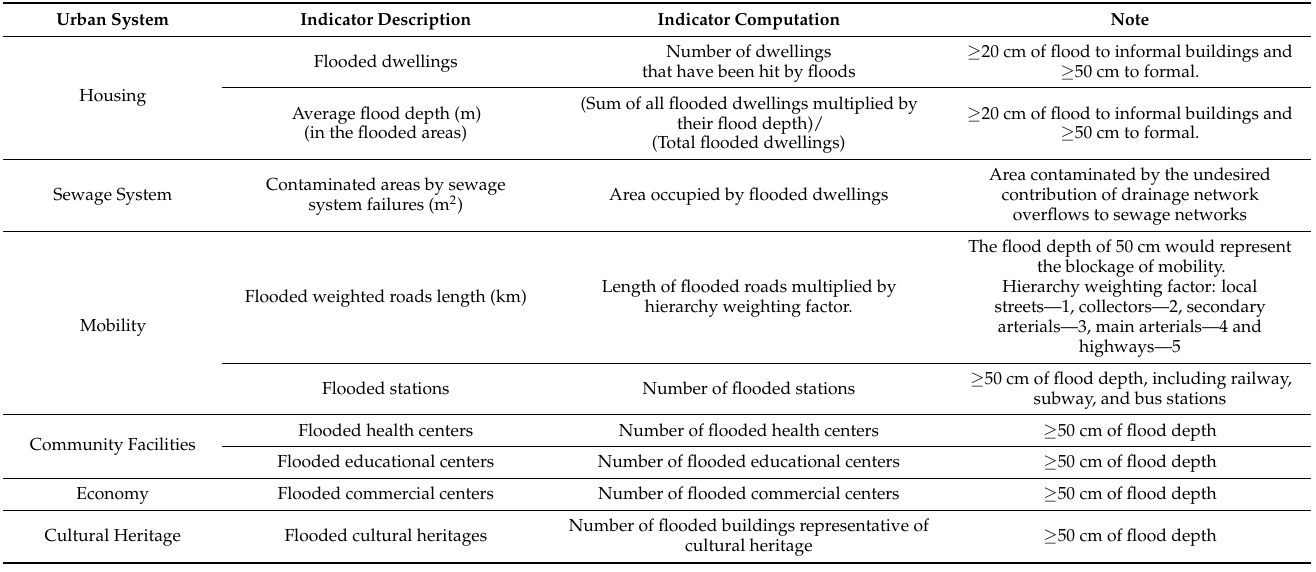
Table 1. Indicators of urban drainage